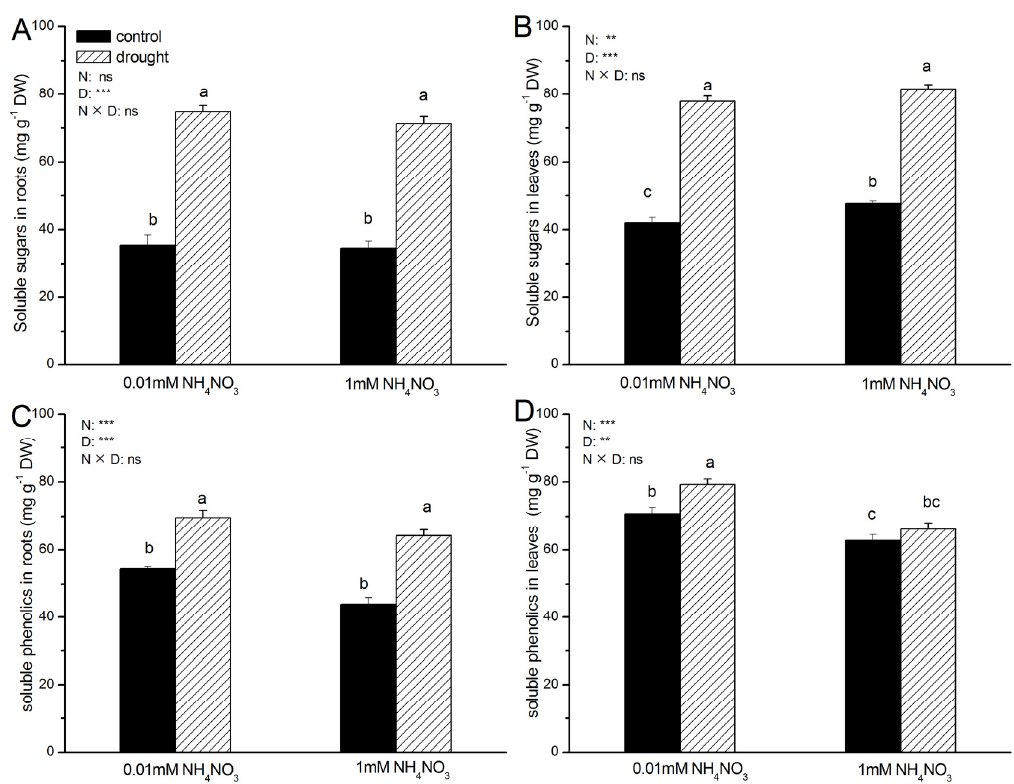
Figure 1. Soluble sugars and soluble phenolics in roots ( A , C ) and leaves ( B , D ) of Populus simonii as affected by nitrogen supply and drought stress. Data indicate mean ± SE ( n = 6). Different letters in the same column indicate significant differences. N, N supply; D, drought treatment; N × D, interaction of N supply and drought treatment. **, p < 0.01; ***, p < 0.001; ns, not significant.